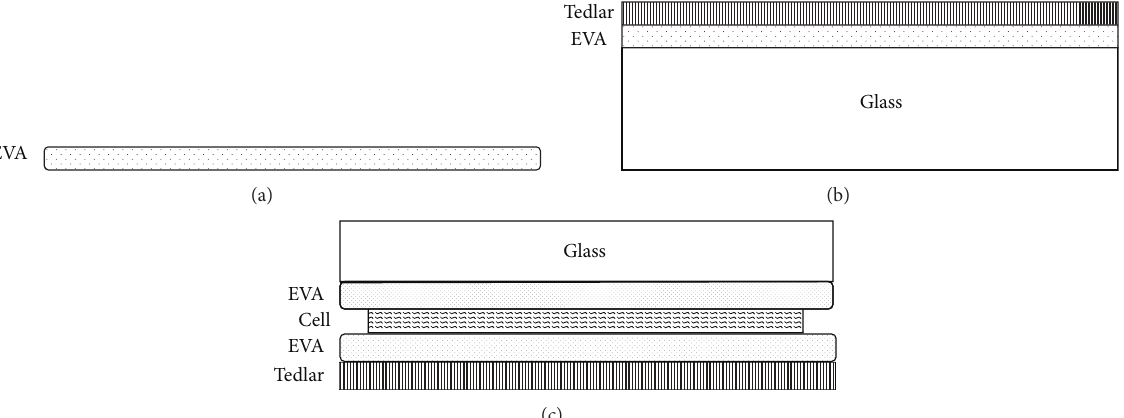
Figure 1: Lamination structures: (a) EVA film for optical transmittance testing, (b) glass/EVA/Tedlar for peel testing, and (c) glass/EVA/cell/ EVA/Tedlar for power testing.